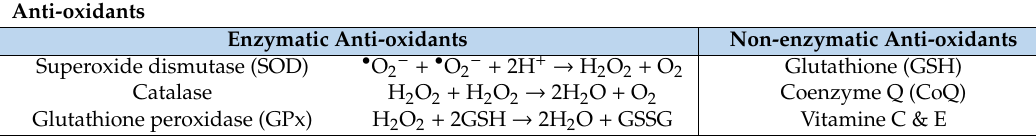
Table 2. A list of antioxidants and their chemical